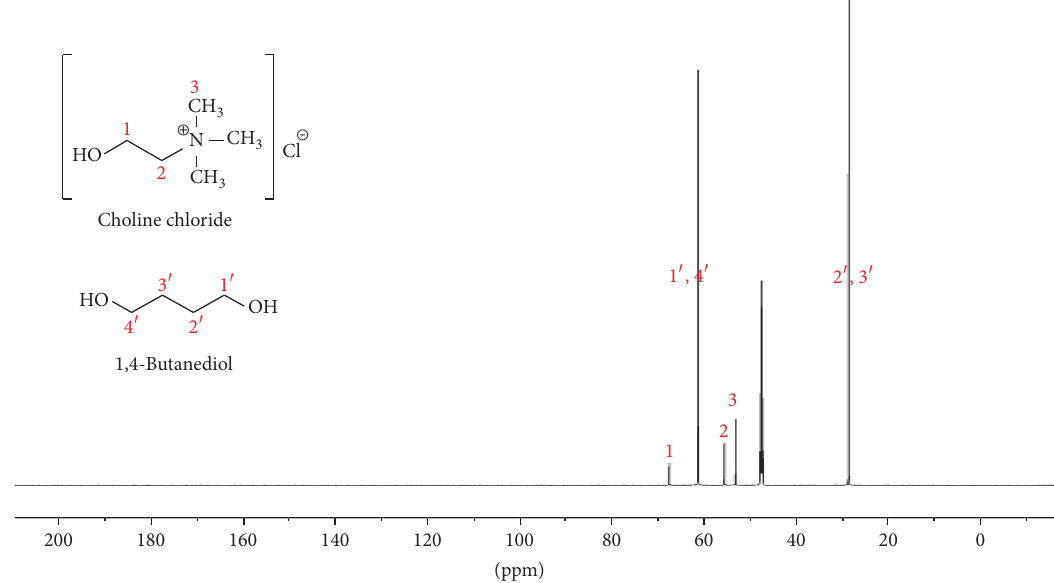
Figure 5: 13 C NMR spectrum of alcohol-based